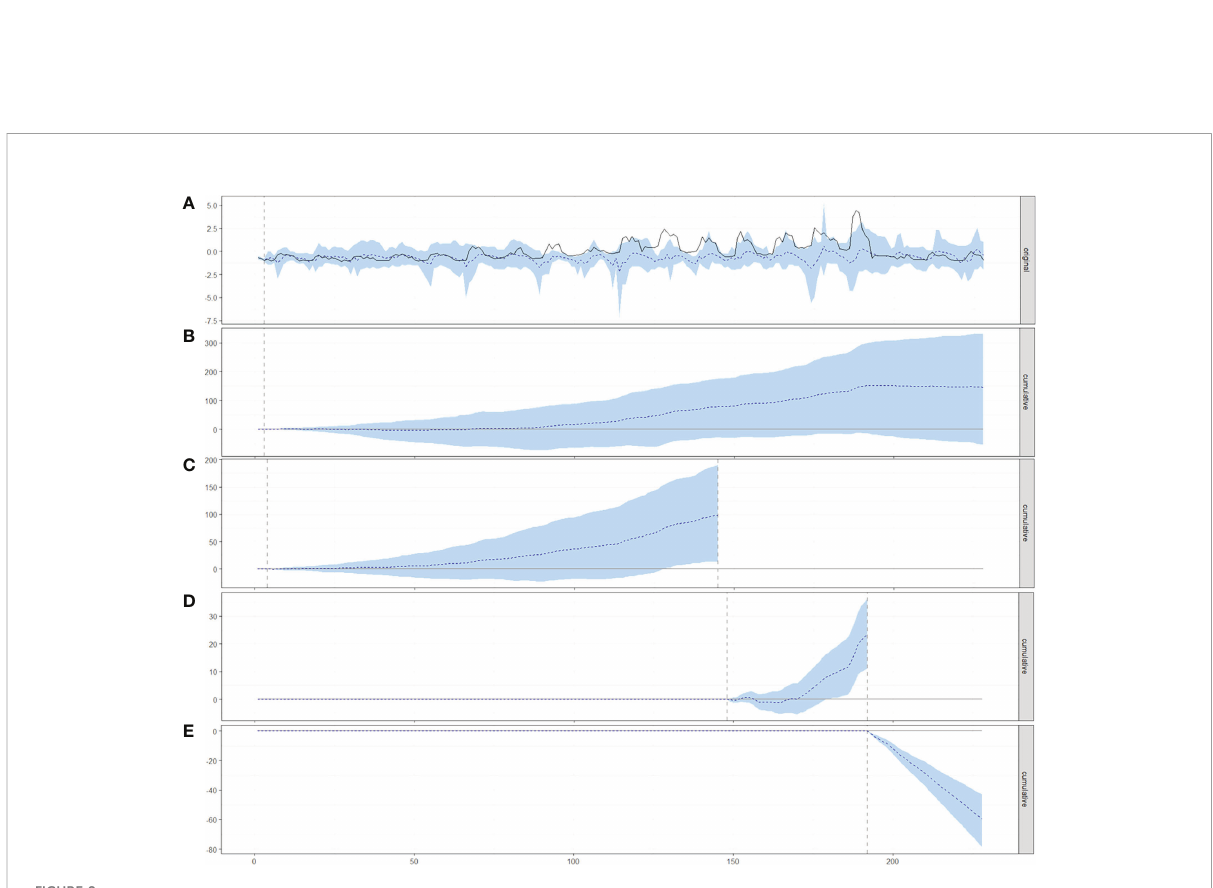
FIGURE 8 (A) Original time series with a counterfactual estimate (dotted line and shaded area) and cumulative results of the causal impact on red sea urchin population density anomaly (dotted) and con fi dence intervals at 95% (shaded) for (B) full-time series, (C) Pre – heatwave, (D) Heatwave, and (E) Post – heatwave models and signi fi cant variables; horizontal axis are the number of months from Jan-2000 (0) to December-2018 (229). The dotted vertical line indicates where the causal effect was